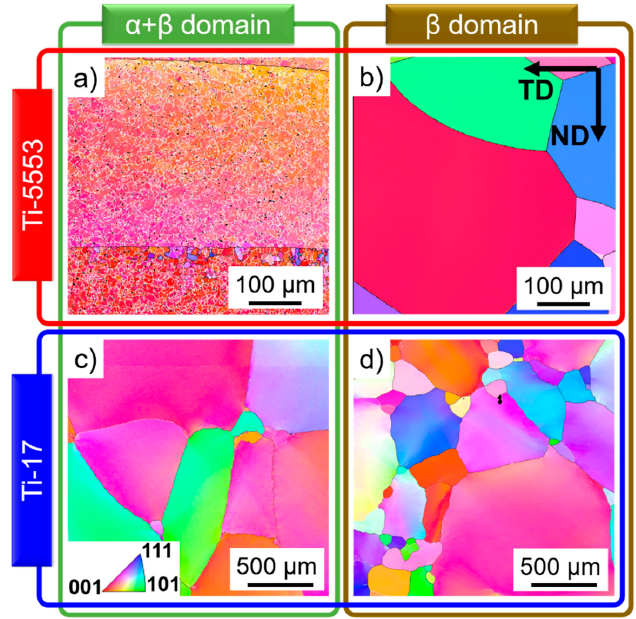
Figure 1. Microstructures before deformation of the ( a , b ) Ti-5553 and ( c , d ) Ti-17 after heat treatment at ( a ) 820 °C for 15 min, ( b ) 920 °C for 5 min, ( c ) 810 °C for 15 min, and ( d ) 970 °C for 15 min. Only the β -phase is indexed in the electron backscattered difraction (EBSD) inverse pole figure maps, and the black lines are HAGBs.